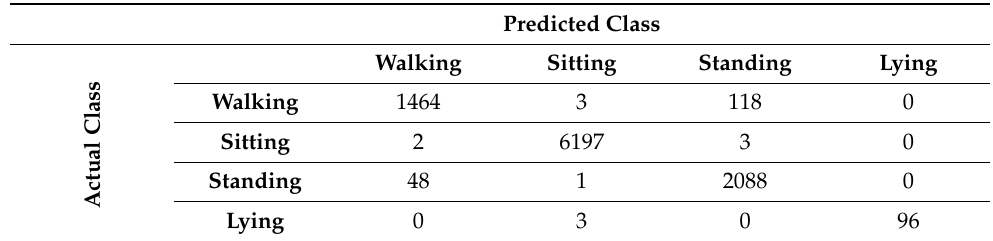
Table 4. Confusion matrix obtained using the proposed LSTM-based PAC system using the test